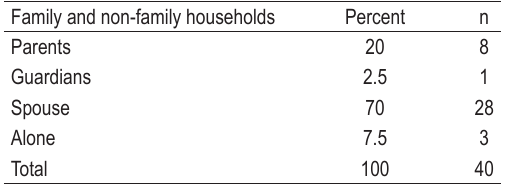
TABLE 7. Family and non‑family households